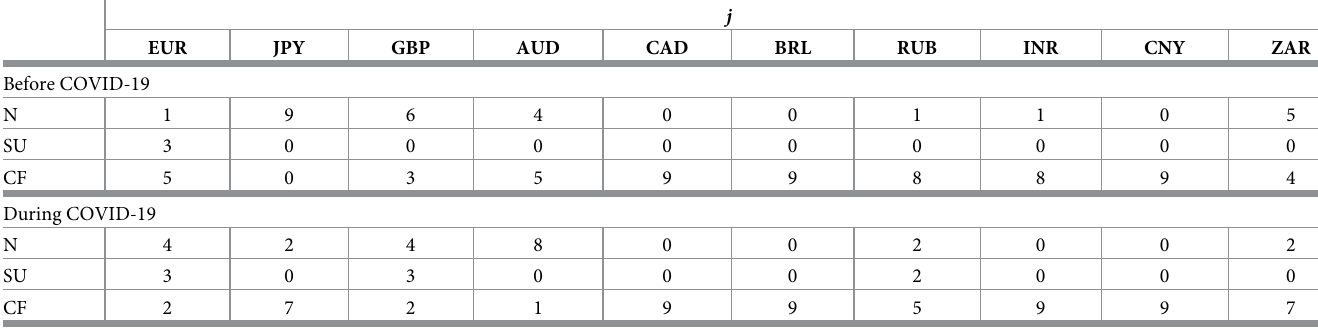
models with the best conditional coverage property. j j�